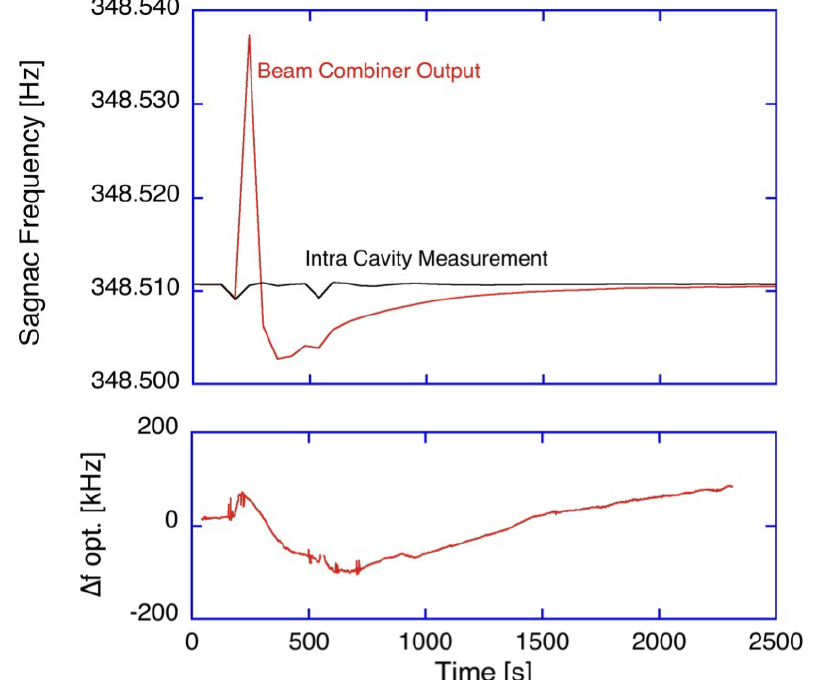
Figure 7. The effect of a small temperature gradient applied to the beam combining prism at the output of the Sagnac interferometer. While the combined beam experiences a more than 25 mHz variation of the beat note, the ring interferometer remains almost unperturbed ( top chart ), as well as the optical frequency inside the ring cavity ( bottom chart